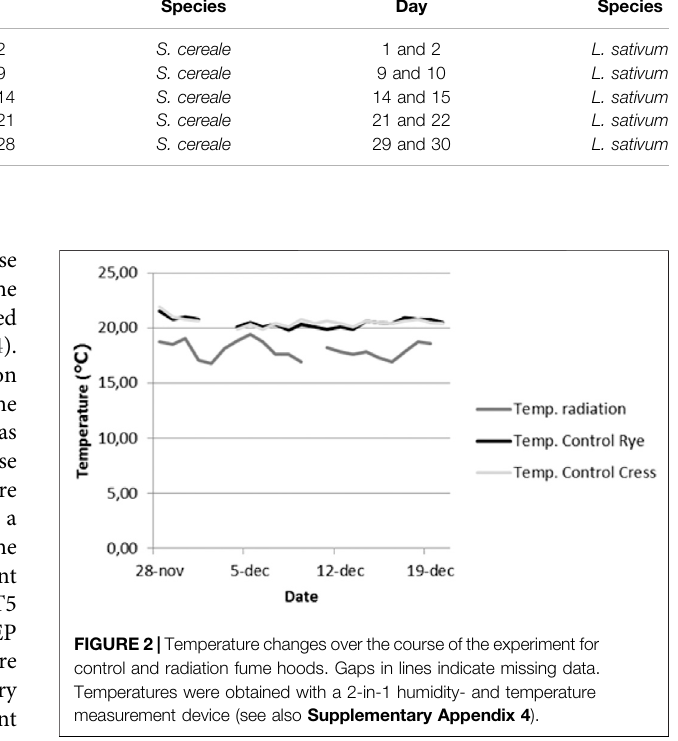
TABLE 1 | Overview of imposed simulated Solar Energetic Particle (SEP) events per plant species ( n (cid:2) 12 per treatment). A SEP-event was simulated by exposing the plant material 22.51 h to a 60 Co-source with a dose rate of 1,333 μ Gy h − 1 . Days are counted from the start of the experiment. Treatment code